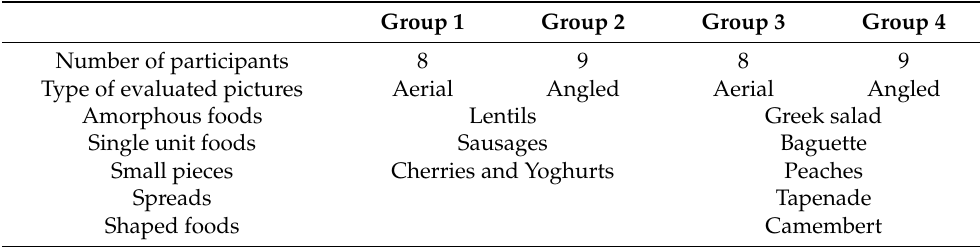
Table 1. Menus of the photograph evaluation (June/July